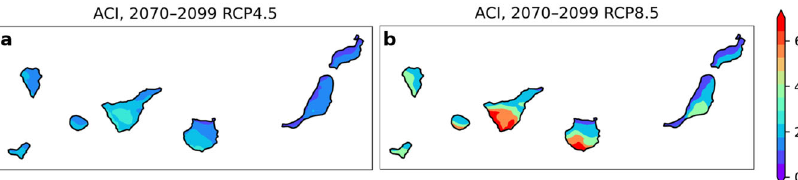
Fig. 8 Maps of future changes in aridity for the two scenarios analyzed. Aridity Change Index (ACI) for 2070 – 2099 RCP4.5 ( a ) and RCP8.5 ( b ). All three models coincide in a positive change of ACI at all